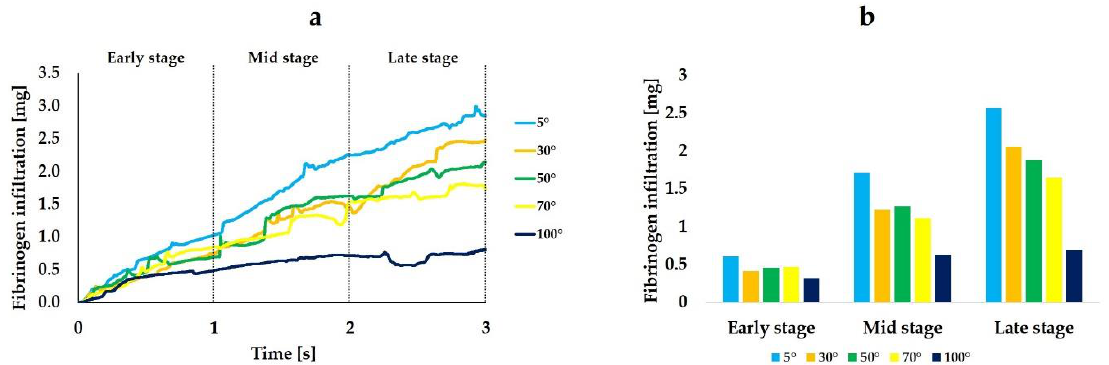
Figure 3. Fibrinogen infiltration (mg) varying with different levels of hydrophilicity or hydrophobicity of the implant surfaces. Line plot graphs ( a ) and integral-based histograms in the early, mid, and late stages ( b ).